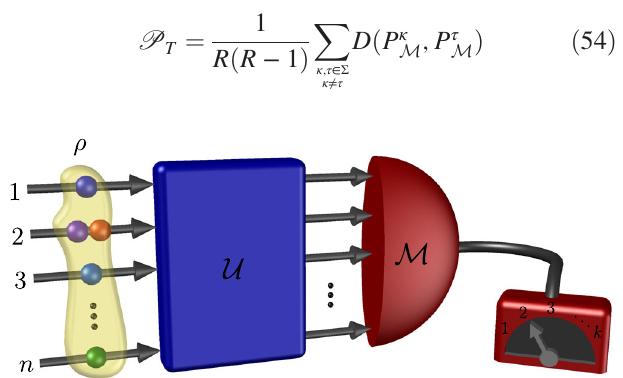
FIG. 5. General setting of a many-particle interference experi- ment with a state ρ of N partially distinguishable particles in n modes (colored balls covered by a yellow envelope illustrating correlations in the internal degrees of freedom). The external state ρ E evolves according to a many-particle, possibly interacting, unitary U ∈ U ð n N Þ (illustrated in blue) and is measured by a POVM M with outcomes 1 ; … ; k (illustrated in red). As a consequence of wave-particle duality, the visibility of many- particle interference is bounded by the particles ’ degree of